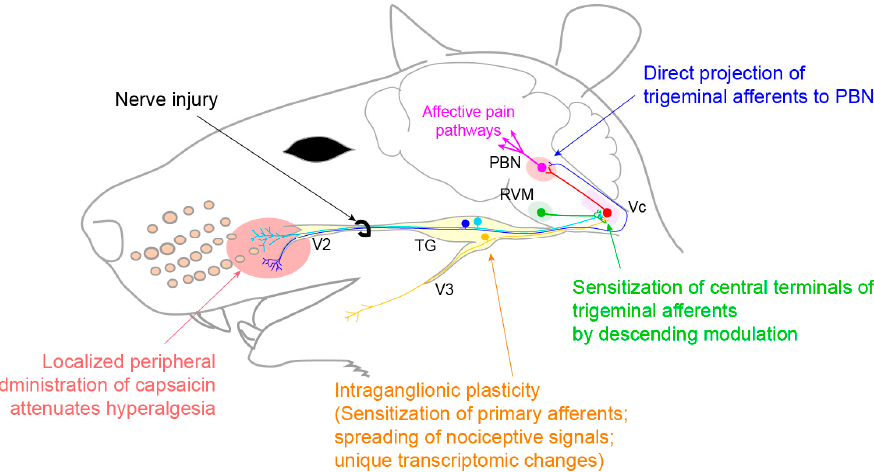
Figure 4. Mechanistic contribution of the nociceptive primary afferents to chronic orofacial neuro- pathic pain. Chronic constriction nerve injury (CCI) of the infraorbital nerve (ION), a part of V2, induces widespread unique transcriptomic changes in TG. The spreading of a nociceptive signal between the V2 and V3 neurons within TG may contribute to extraterritorial hyperalgesia. Central terminals of trigeminal afferents within the trigeminal subnucleus caudalis (Vc) are sensitized by descending facilitatory inputs from the rostral ventromedial medulla (RVM). A subset of trigeminal afferents directly projects to the parabrachial nucleus (PBN), which is a hub of affective pain pathways, without relaying at the Vc. The localized administration of capsaicin—which selectively defunctionalizes nociceptive afferents—to orofacial tissues attenuates long-lasting orofacial neuro- pathic pain, both in humans and rodents.